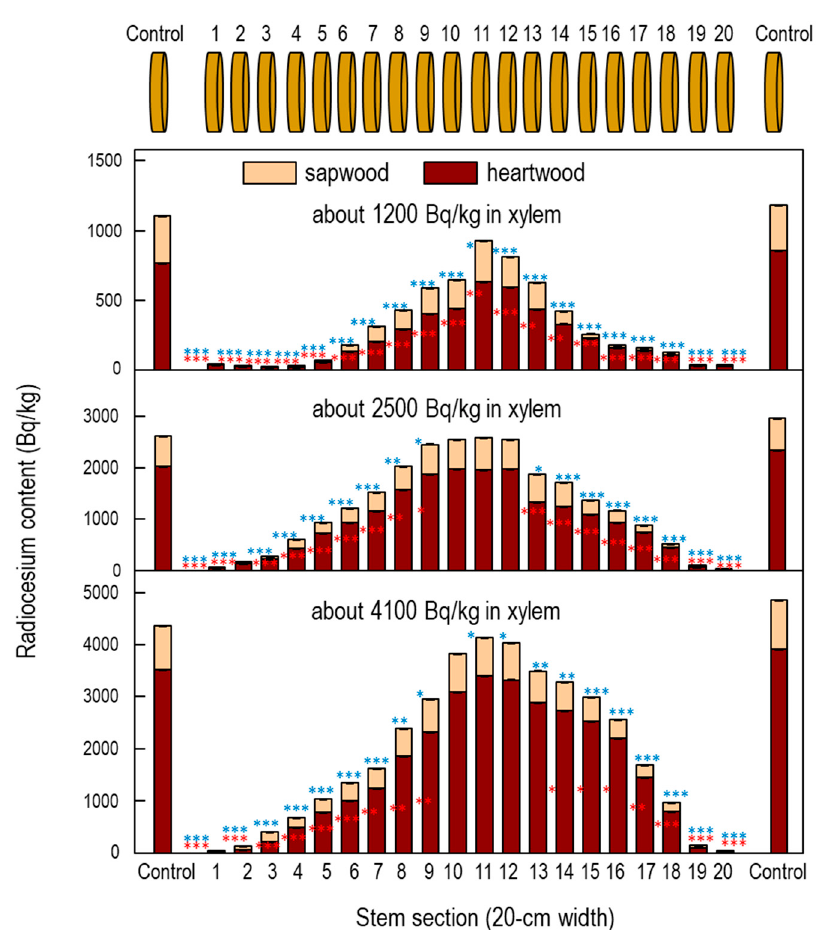
Figure 2. Ponding experiments for the stems of Japanese cedar from Fukushima forest. Bar plot the average ± SD of the data from three measurements. Significance at the * p < 0.05, ** p < 0.01, and *** p < 0.001 levels compared with non-treated stems (red, heartwood; blue, sapwood) in Student’s t-test and indicated.